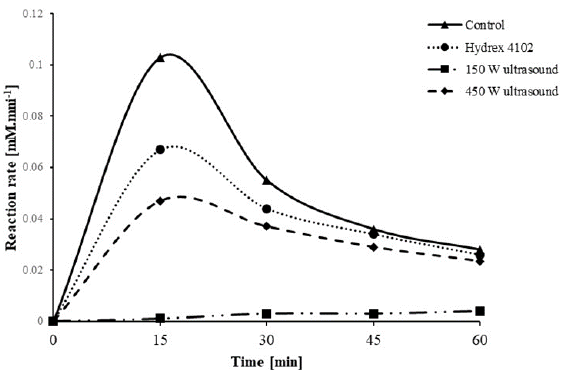
Figure 10. Comparative calcium carbonate precipitation rate of treated and untreated water sam- ples.